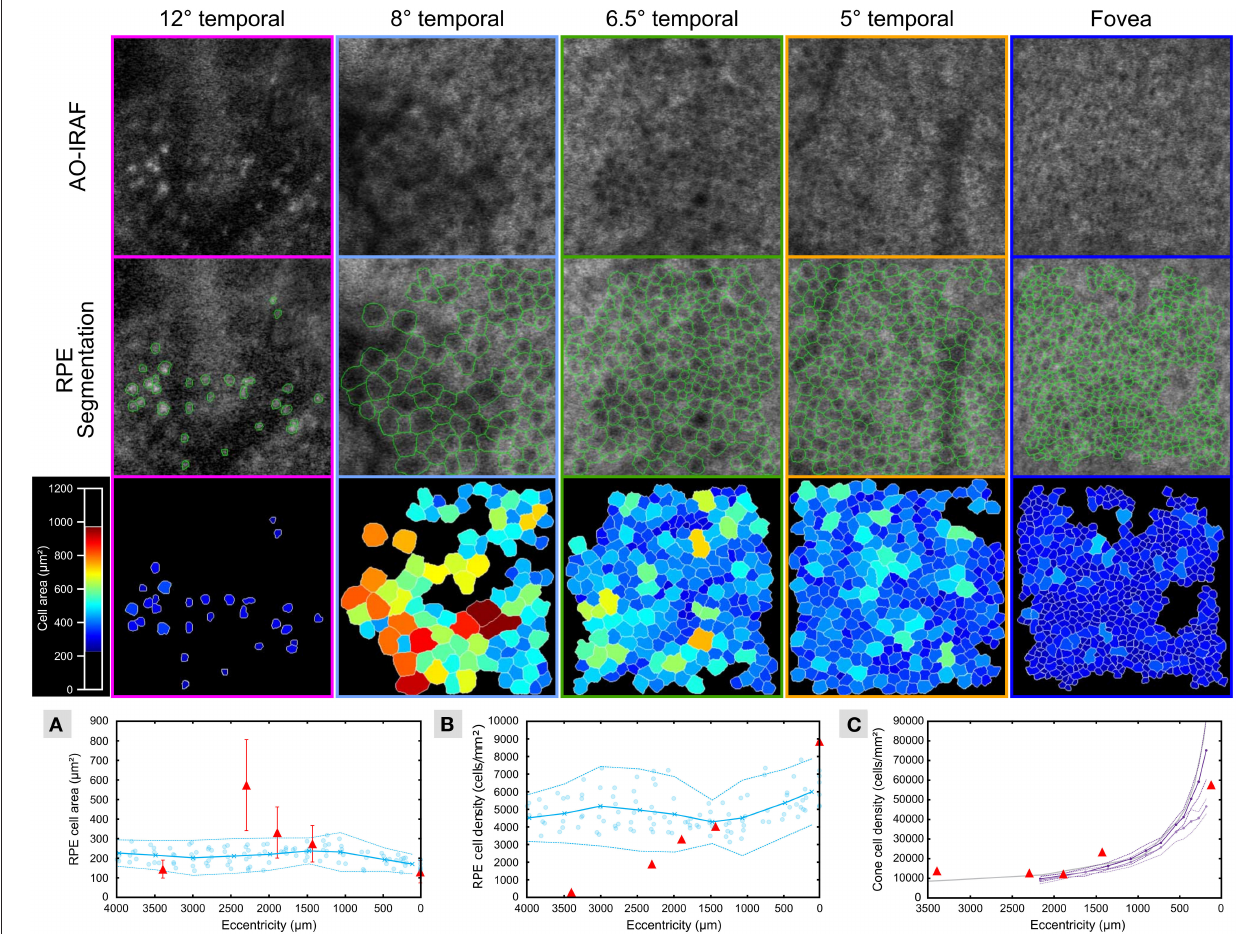
FIGURE 3 | RPE cells are altered in TM outside of the lesion area. AO-IRAF images from patient 1 (top row; see Figures 2E–I ) were semi-automatically segmented (middle row; green outlines). The bottom row of images shows the segmentation images colored by cell area. Near the fovea (far right images), the cells were relatively uniform in size across the region of interest, while cell size heterogeneity increased with increasing eccentricity approaching the margin of the lesion. Within the lesion (left column), some punctate hyper-AF structures were seen but they did not resemble normal RPE cells. Quantitative plots compare the RPE cell area (A) and density (B) from this patient (red triangles in A and B, respectively) to the normative data from Granger et al. (29) (blue circles are individual data points; circle markers and solid line show mean; dotted lines are ± 2 SD). Average cell area was greater than the normal range at the margin of the lesion (see data point at approximately 2,300 µ m) and greater than 400 µ m away from the lesion (see data point at approximately 1,900 µ m), while closer to the fovea (approximately 1,400 µ m) and at the fovea (0 µ m) the average cell area was within the normal range. Similarly, RPE cell density began to diverge from the normal range at the 1,900 µ m measurement point and fell below 2 standard deviations from normal at the lesion margin (approximately 2,300 µ m) and within the lesion (approximately 3,400 µ m). Cone density was measured in 100 × 100 µ m FOV within each RPE ROI (C) and was close to the range expected for normal eyes (violet and purple lines plot the mean cone density from the in vivo AOSLO data of Song et al. (30) for their younger and older cohort, respectively; dashed lines are ± 2SEM; gray line is the mean cone density from the histology data of Curcio et al. (31).